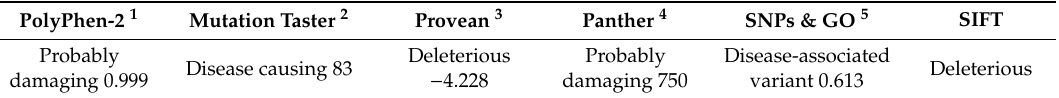
Table 1. Overview about di ff erent prediction tools analyzing the desmin ( DES) mutation